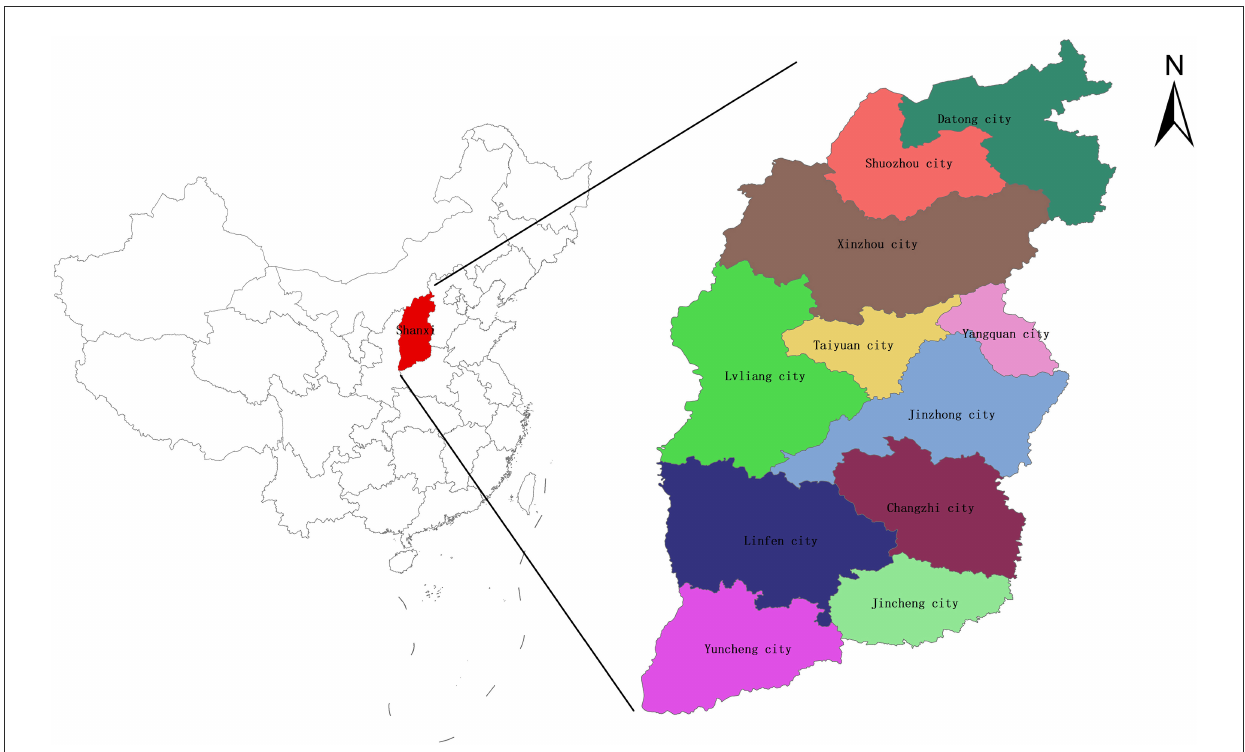
FIGURE1 Geographical location of